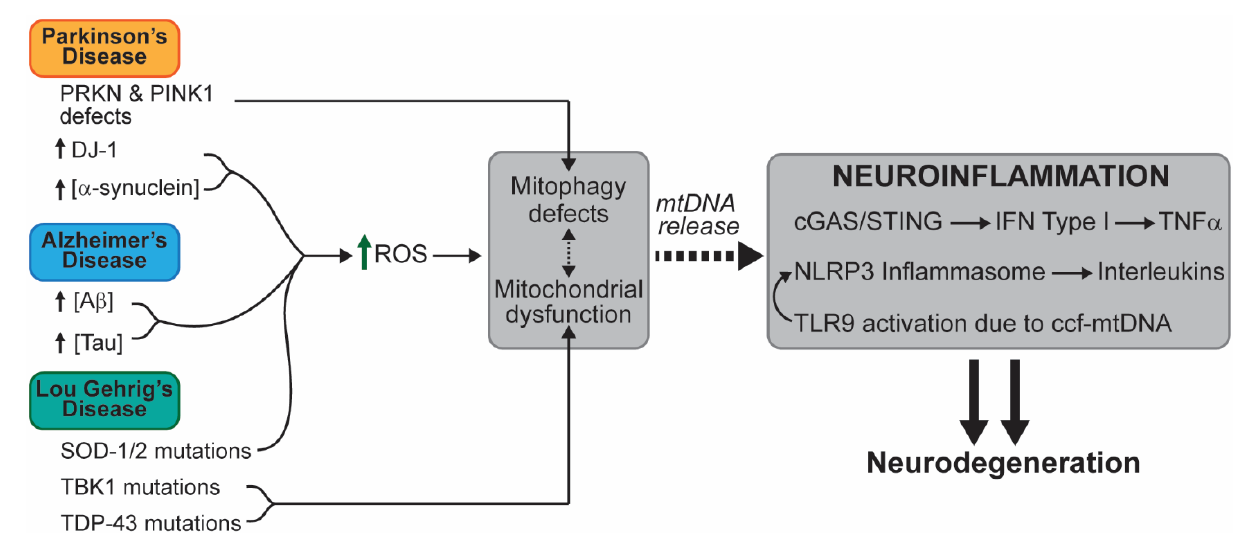
Figure 3. A schematic representation of mtDNA-mediated inflammation in relevant neurodegenerative diseases. The known alterations that lead to inflammation and neurodegenerative disease are presented. Different mutations or aberrancies lead to accumulation of damage in different ways. We propose that accumulation of defective mitochondrial due to impaired mitophagy and the accumulation of oxidative stress are common factors that link mtDNA-dependent inflammation within these pathologies. Abbreviations: amyloid-beta (A β ); NOD-like receptor, pyrin containing protein 3 (NLRP3); reactive oxygen species (ROS); superoxide dismutase (SOD); TAR DNA-binding protein 43 (TDP-43); TANK-binding kinase 1